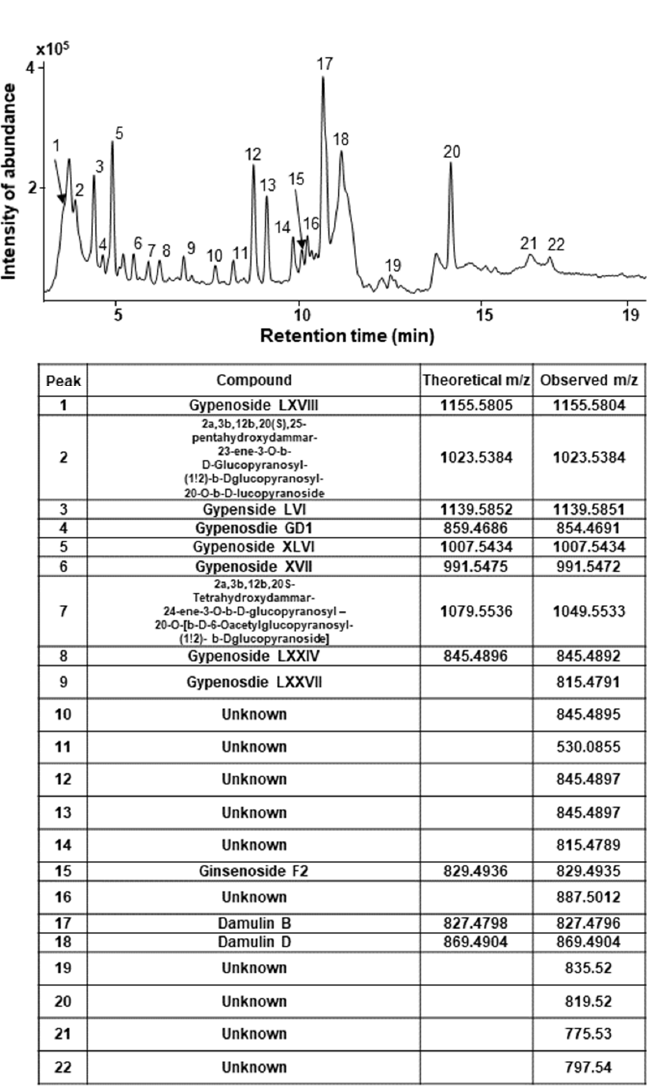
Figure 6. LC ‐ MS spectrum of GPHD. GPHD was analyzed by UHPLC ‐ Q/TOF MS in negative ion mode. Several types of gypenosides, hydroxylated dammarane ‐ type glycosides, and damulins